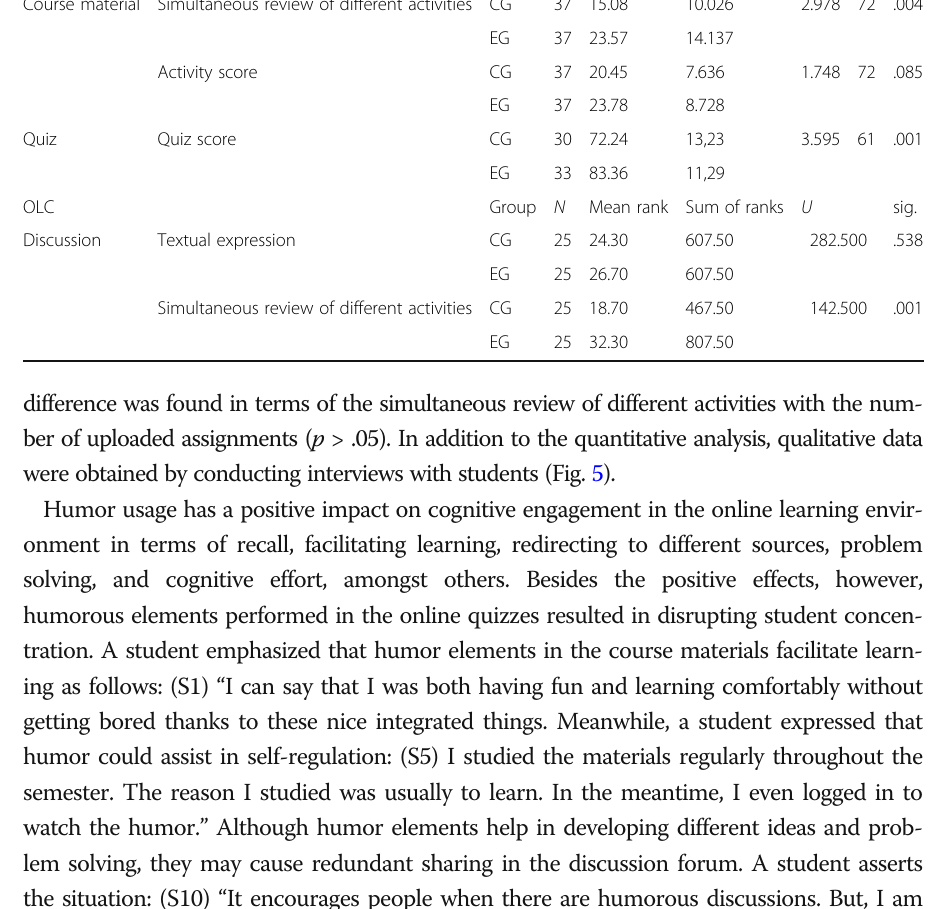
Table 8 Descriptive statistics for assignments